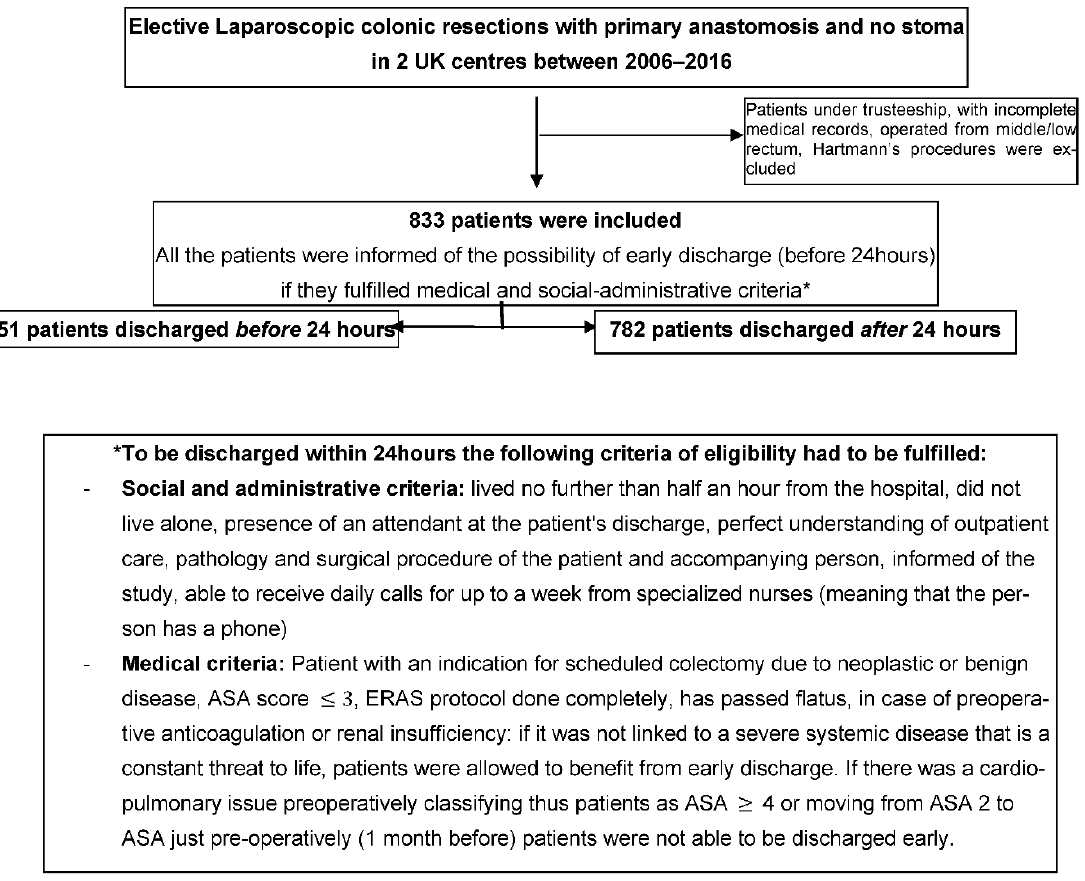
Figure 1. Flow chart. Figure 1. Flow Table 1. Enhanced recovery program.